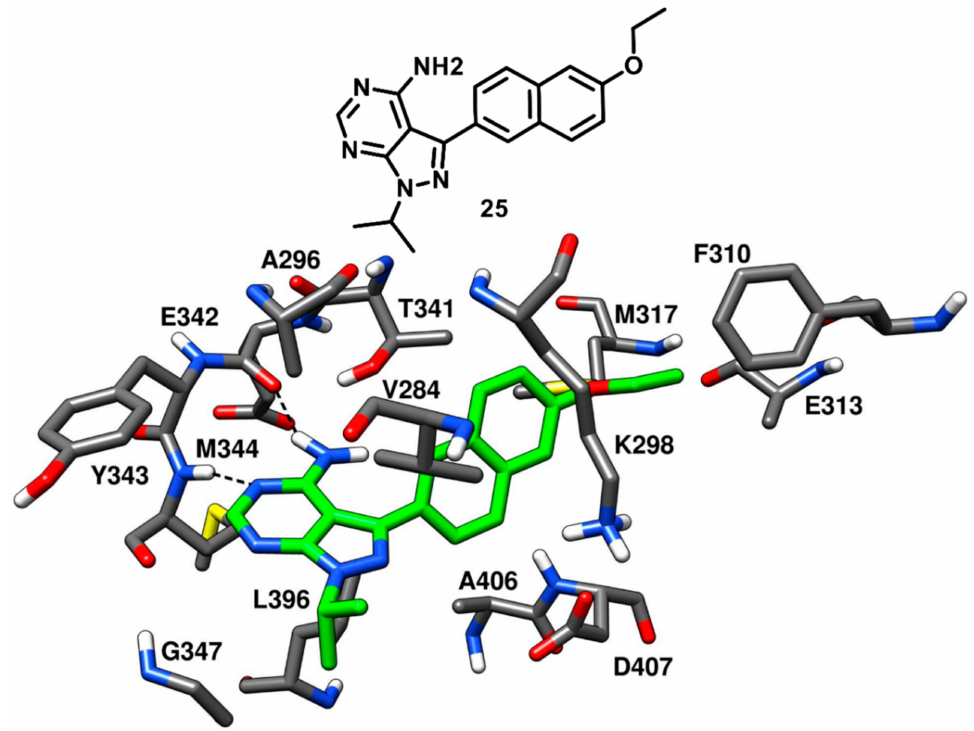
Figure 21. 2D structure of 25 . X-ray structures of c-Src kinase in complex with 25 (PDB ID: 3UQF). Active site residues of c-Src kinase and the enzyme–inhibitor H-bond interactions are